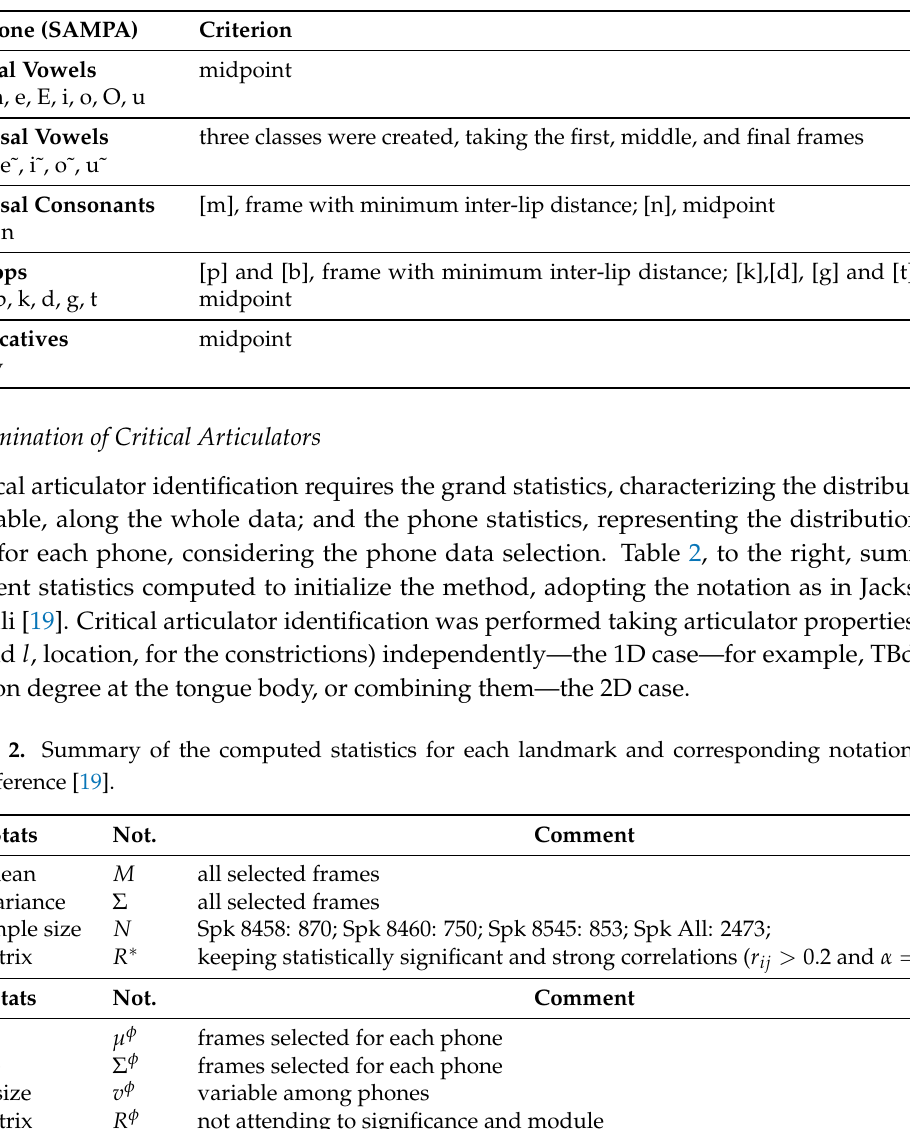
Table 1. Summary of the criteria used for selecting the representative frame for particular phones.